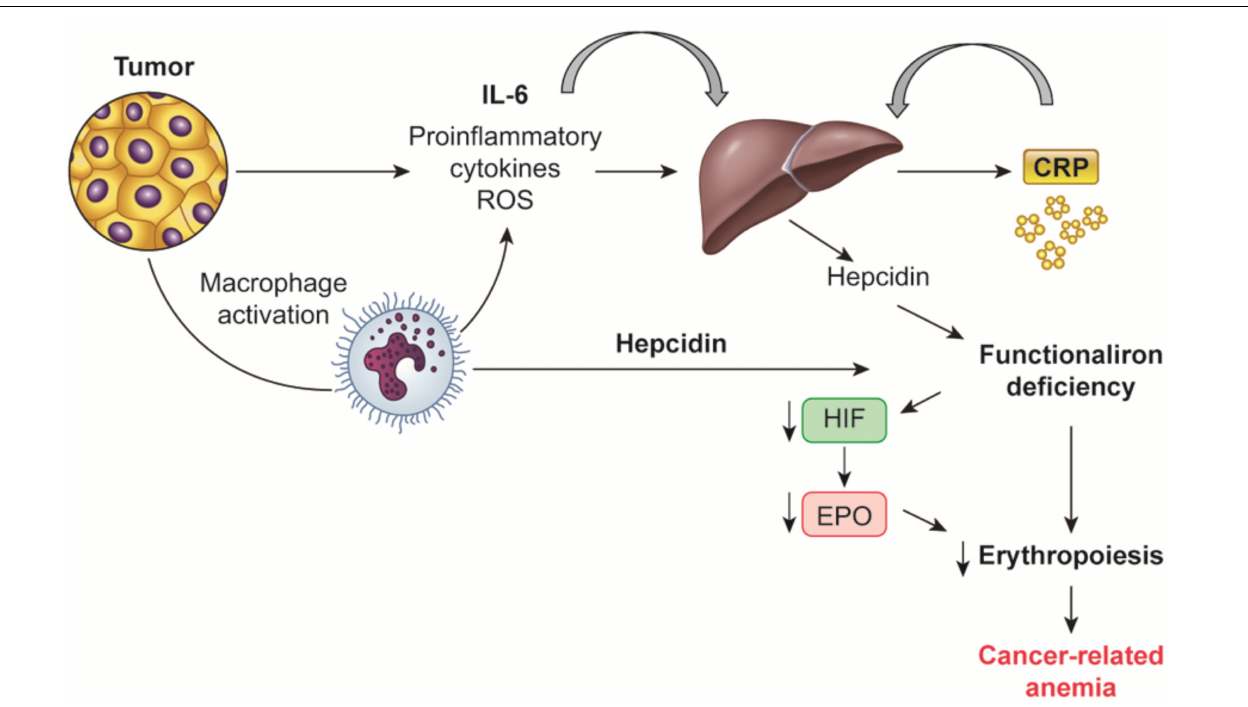
FIGURE 1 | Mechanisms regulating hepcidin synthesis in cancer-related anemia. Tumor and macrophage-derived proinflammatory cytokines, mainly IL-6, induce the liver synthesis of hepcidin, which in turn is responsible of the “functional iron deficiency” typical of cancer-related anemia. Also macrophages by themselves are able to synthesized hepcidin. IL, Interleukin; CRP, C-reactive protein; HIF, hypoxia inducible factor; EPO, erythropoietin.